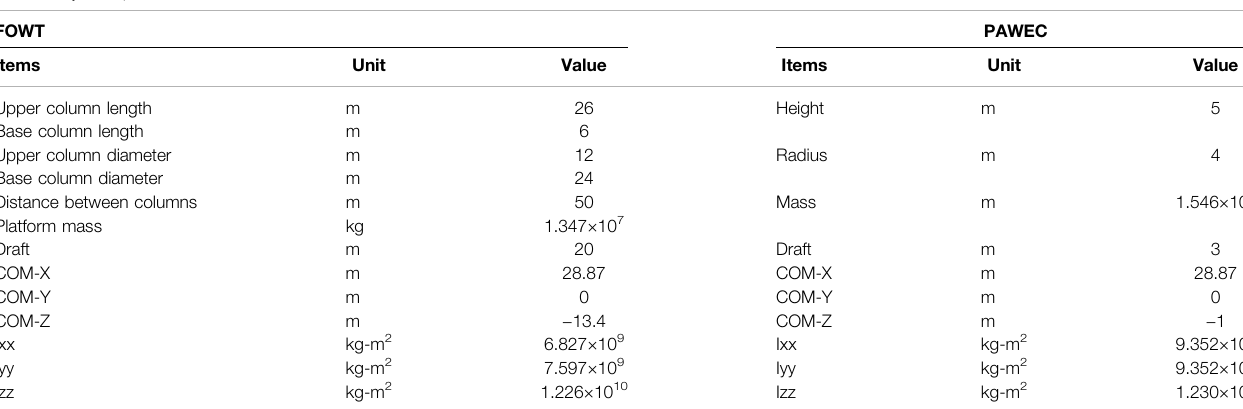
TABLE 1 | Main parameters of the FOWT and PAWEC. FOWT